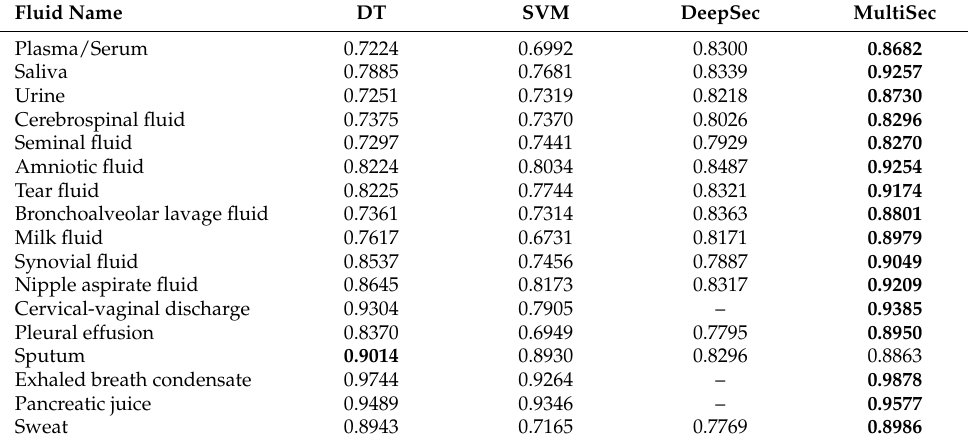
Table A1. ACC benchmarks of MultiSec and compared methods on the independent testing datasets of 17 human body fluids.